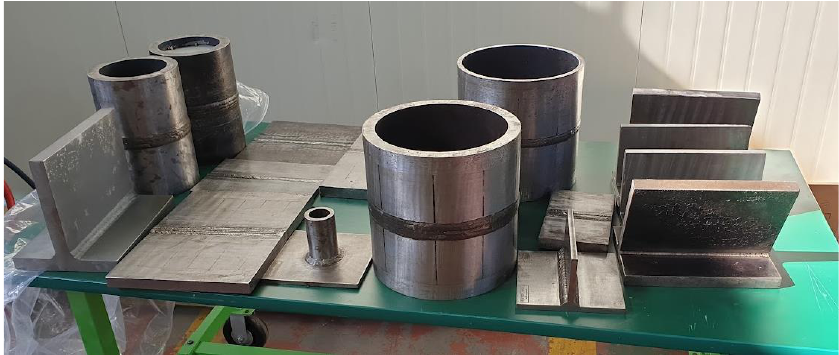
Figure 2. Specimens used in the acquisition of data.